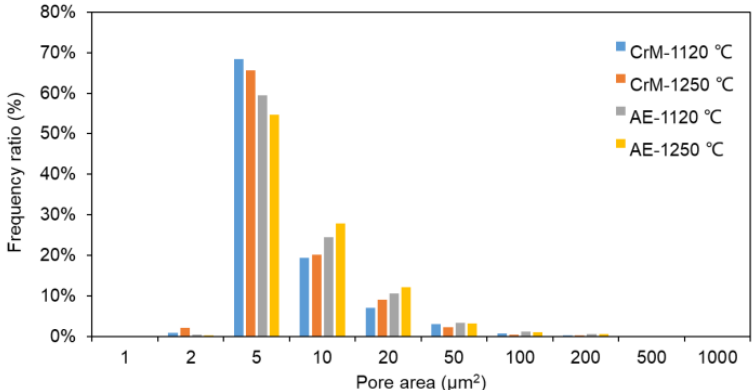
Figure 2. The morphology of porosity and sintering necks at different levels of density: ( a ) 6.75 g/cm 3 (porosity 14.23%), ( b ) 7.00 g/cm 3 (porosity 11.05%), ( c ) 7.05 g/cm 3 (porosity 10.4%), and ( d ) 7.15 g/cm 3 (porosity 9.15%).